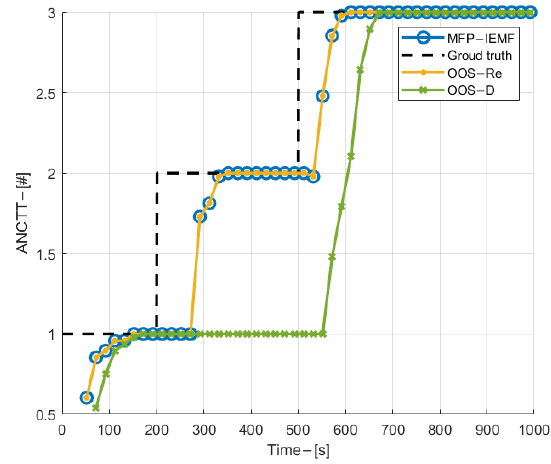
Figure 9. ANCTTs in experiment 2.